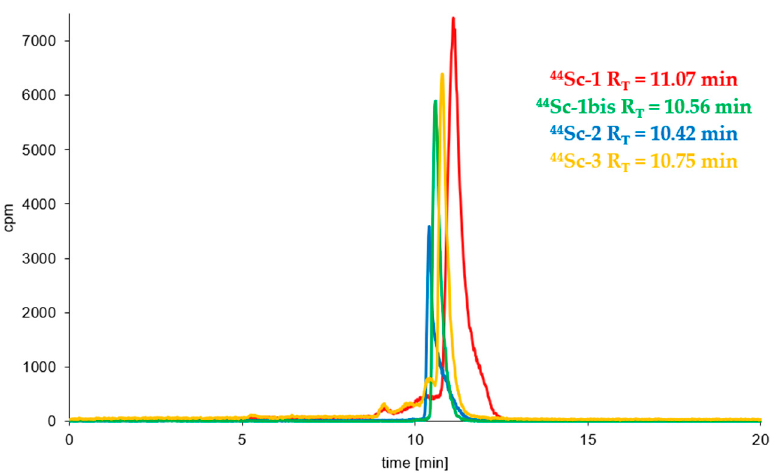
Figure 6. RP-HPLC radiochromatograms of the aqueous phase after lipophilicity experiment for 44 Sc-1 , 44 Sc-1bis , 44 Sc-3 (System 3) and 44 Sc-2 (System 4) radioconjugates.